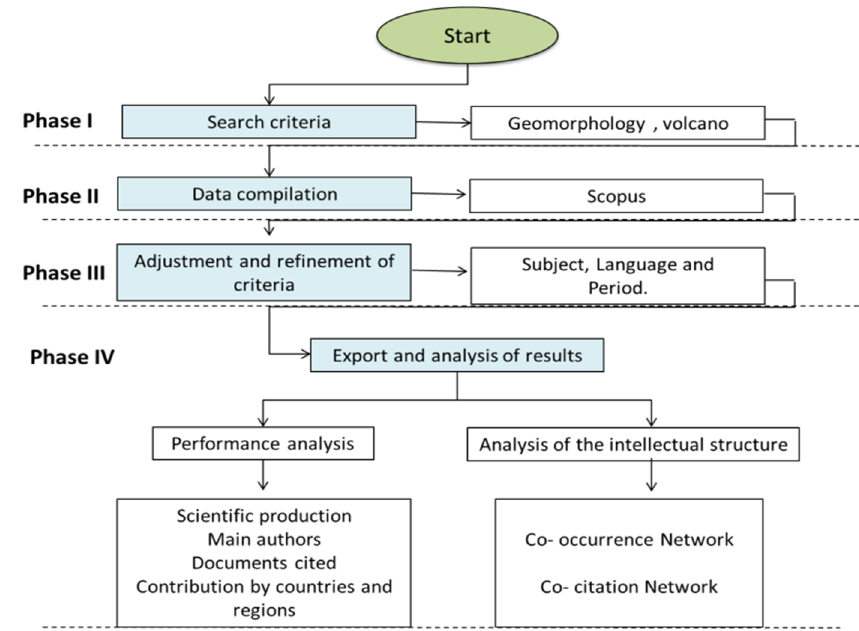
Figure 1. Scheme of the methodology applied in this study.